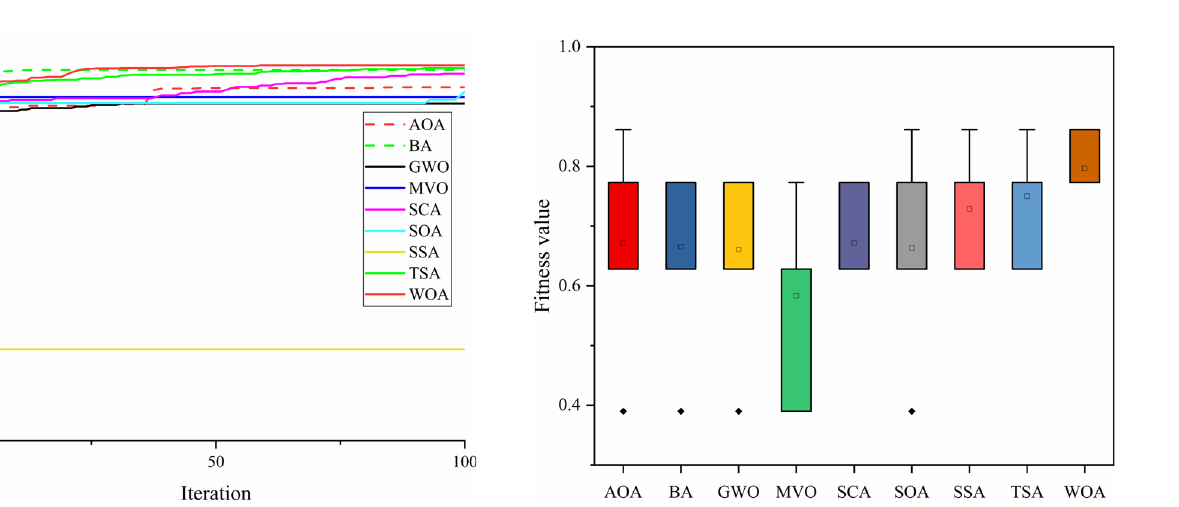
Fig. 9 The evolution curves of the algorithms for case 3